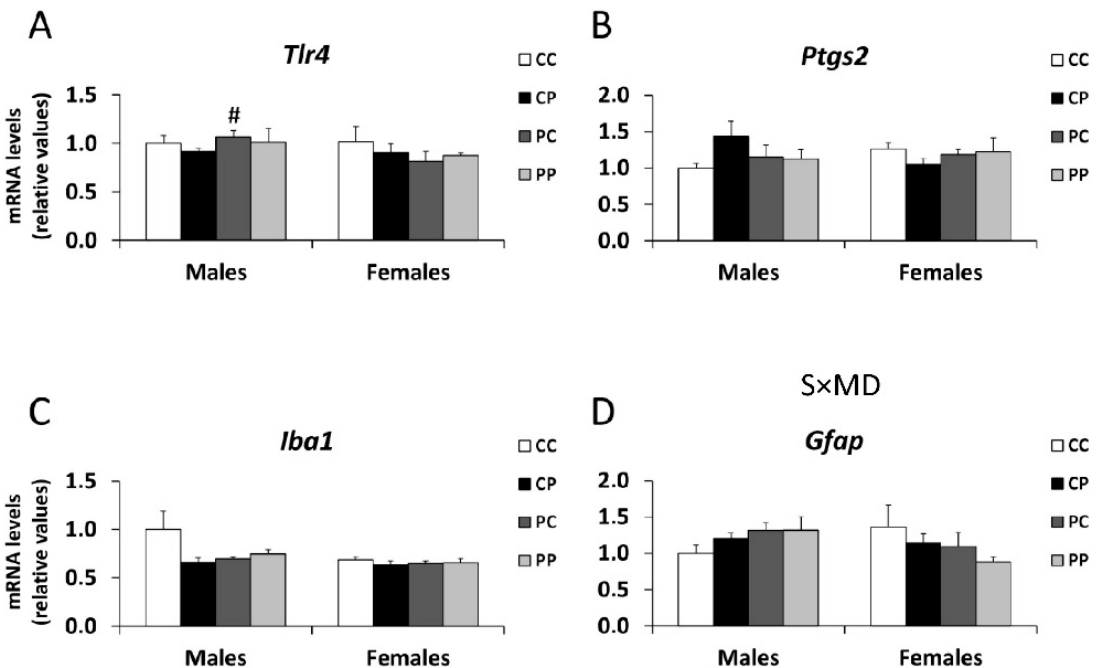
Figure 5. Effect of maternal and/or offspring exposure to a free-choice palatable (P) diet on the relative mRNA levels of: Tlr4 ( A ), Ptgs2 ( B ), Iba1 ( C ) and Gfap ( D ) in the prefrontal cortex of male and female offspring in adulthood. Data are expressed as the mean ± S.E.M. ( n = 6). Student´s t test: # p < 0.05 vs. CP males or CP females. SxMD: sex and maternal diet interaction.